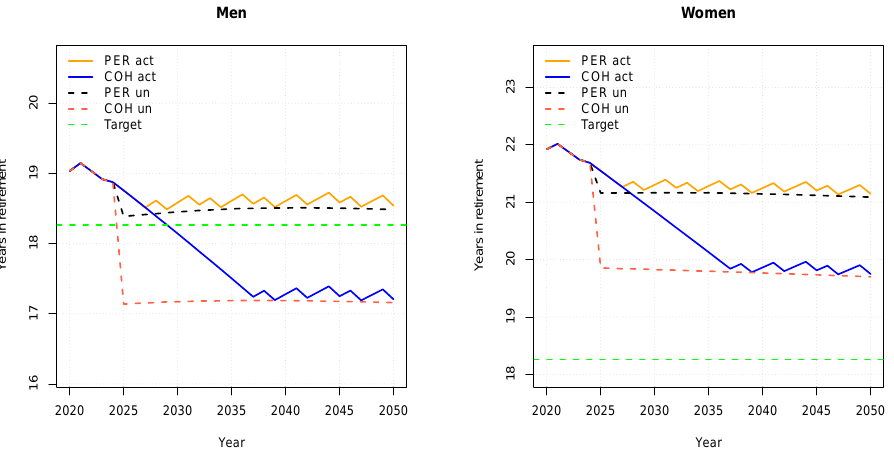
Figure 3. NLD: Expected years in retirement for each sex based on period and cohort projections. The expected benefit duration is forecasted to drop to 18.76 (21.54) years for men (women) in 2025, when the indexation rule comes into force, and will remain stable around 18.60 (21.30) years for men (women) until 2050—nevertheless always above the target benefit duration. The key conclusion is that the use of cohort instead of period life expectancy in the indexation formula and the elimination of The Netherlands’ «extra provisions» would significantly reduce the expected years in retirement to 17.15 (19.70) years for men (women) in 2050, well aligned with the 18.26 years (total population) target. Finally, Figure 4 plots the forecast of the official (legislated) desired standard retirement age and age with remaining cohort life expectancy equal to the 18.26 years target, plotted by